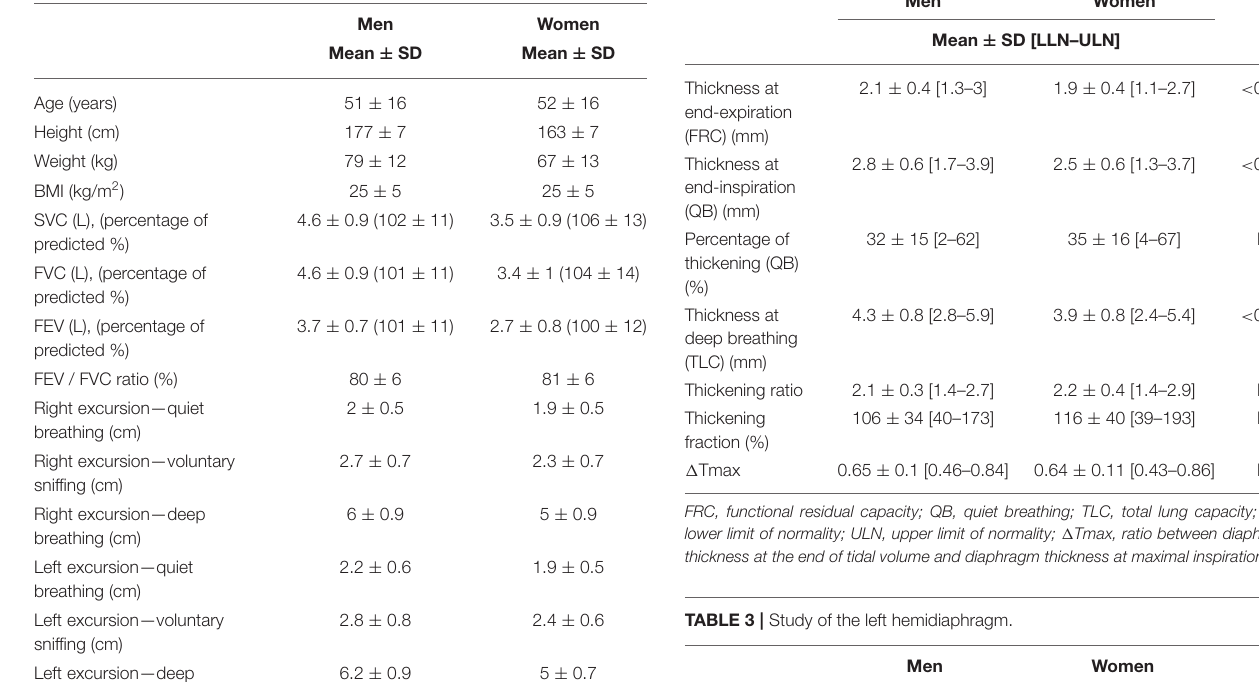
TABLE 1 | Study population: anthropometric data, pulmonary function tests and excursions of both hemidiaphragms recorded by M-mode ultrasonography.